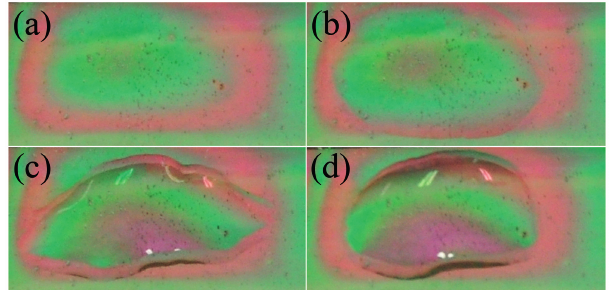
Figure 4. The photographs of the surface of MA with different concentrations of GLU ( a ) without any solution; ( b ) with UPW; ( c ) with 20% GLU solution; ( d ) with 60% GLU